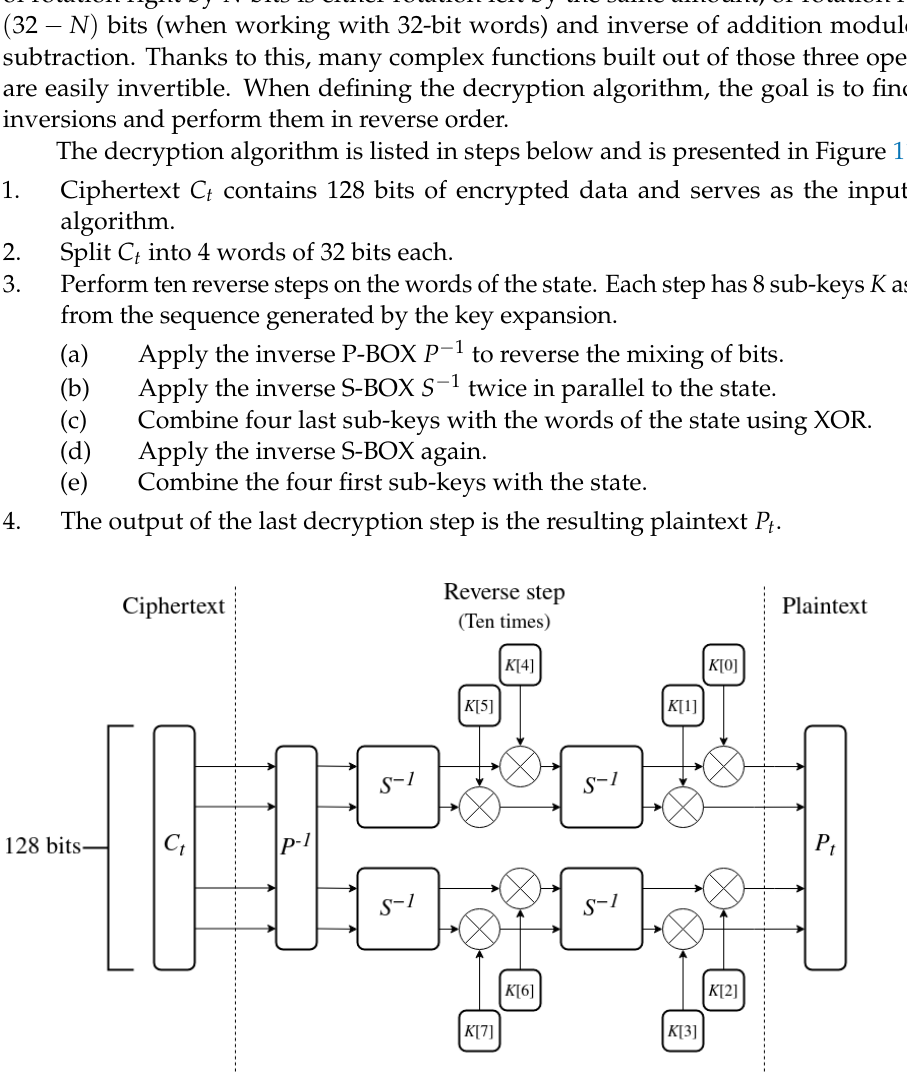
Figure 11. Decryption